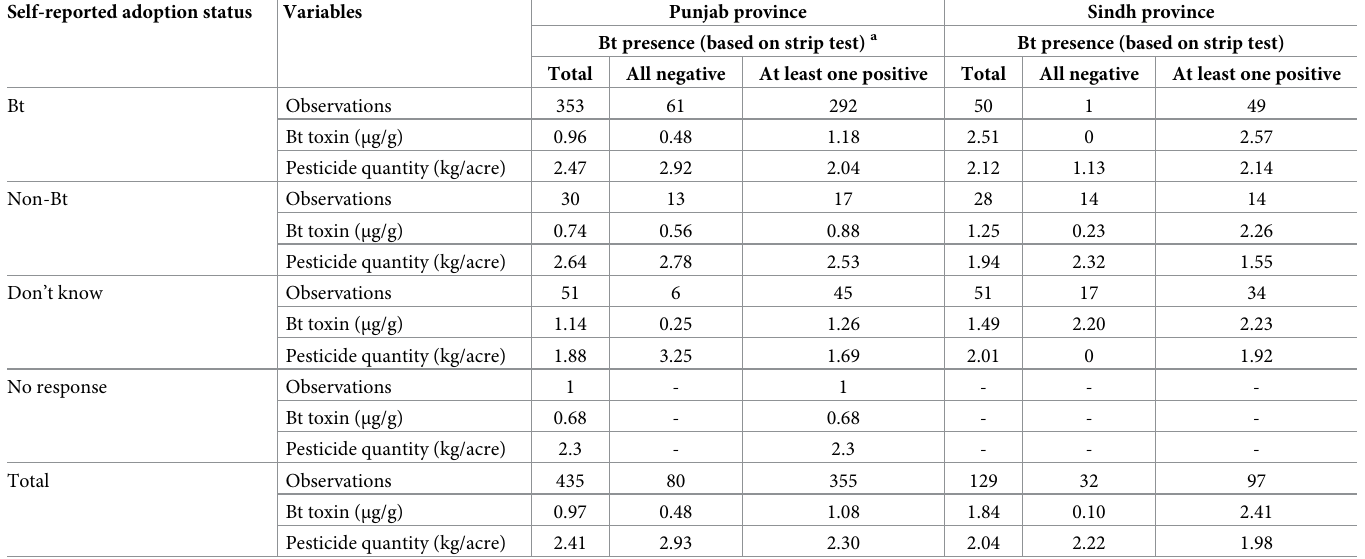
Table 1. Self-reported Bt adoption and results from laboratory analysis on Bt expression by